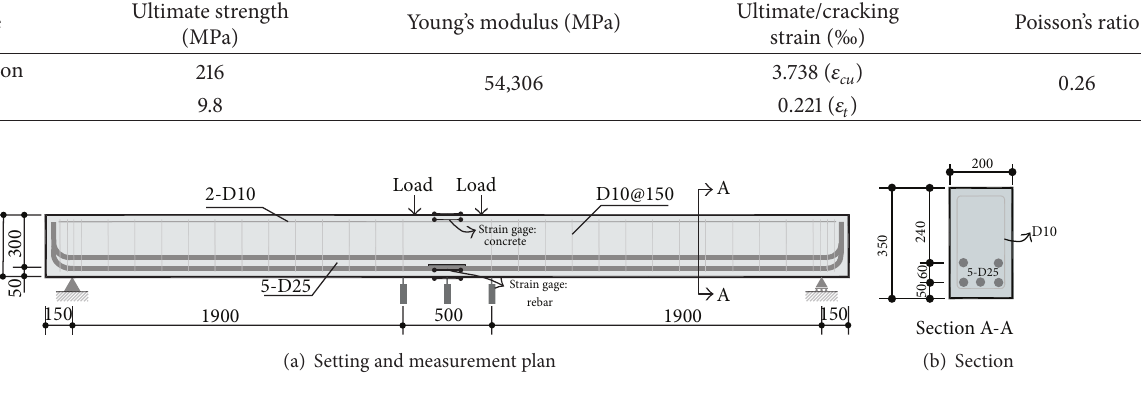
Figure 4: Details of test specimen.